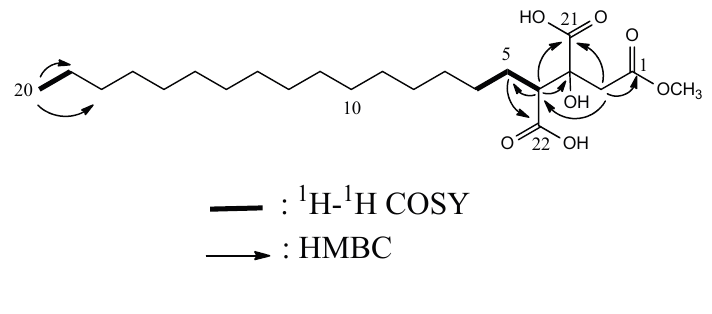
Figure 2. Key HMBC (arrows) correlation of 1 . Table 1. NMR Spectroscopic Data (400 MHz, CD 3 OD) for 1